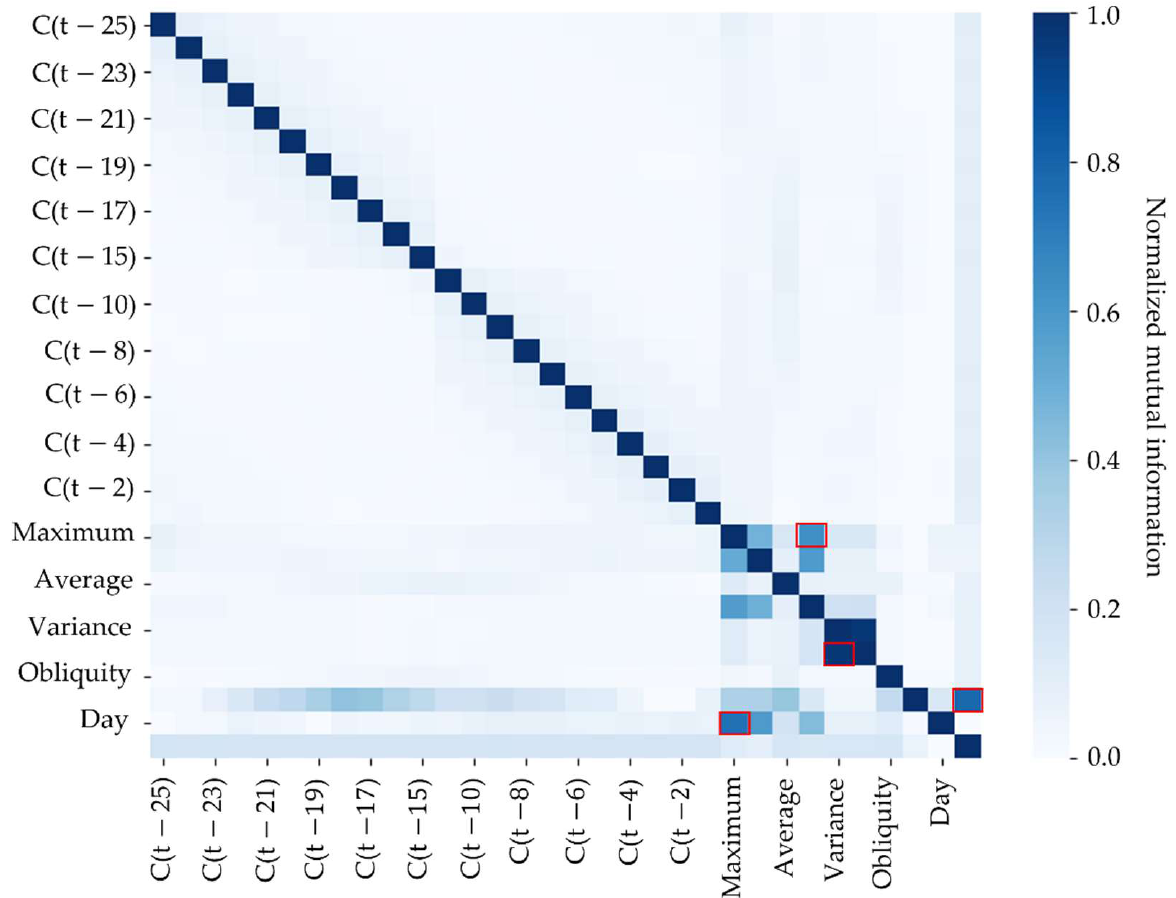
Figure 5. Bar graph of the correction of each feature with the forecast of energy con- sumption.